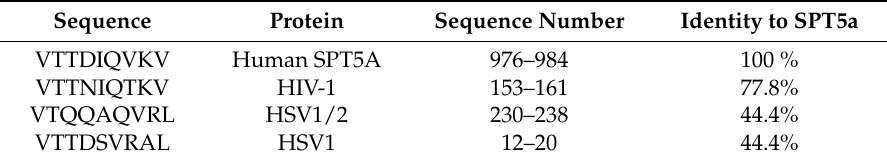
Figure 1. The crystal structure of self peptide VTTDIQVKV SPT5a 976-984 complexed to abacavir and HLA-B*57:01 reveals solvent accessible side chains available for recognition by T cells. ( A ): abacavir is shown in the crystal structure of VTTDIQVKV SPT5a 976-984/HLA-B*57:01 as gold sticks. Binding of abacavir was similar to solved structures of other peptides complexed with abacavir and HLA-B*57:01: PDB code 5U98, gold for carbon, 3VRI, magenta, 3VRJ, white, 3UPR, green. The molecular surface of HLA-B*57:01 is shown as violet for carbon, blue for nitrogen, red for oxygen. ( B ): the crystal structure of VTTDIQVKV SPT5a 976-984 complexed to abacavir and HLA-B*57:01 is shown with the peptide as spheres colored by B factor. P4D and P8K exhibiting the greatest degree of flexibility and solvent exposure. The HLA-B restricted TCR (gray lines) from 2NX5 was superimposed on HLA-B*57:01 to show a conventional binding mode of TCR with respect to peptide and HLA. Table 1. Virus sequences bear homology to a self peptide recognized by CD8 + cells from hypersensitivity patients. Sequence